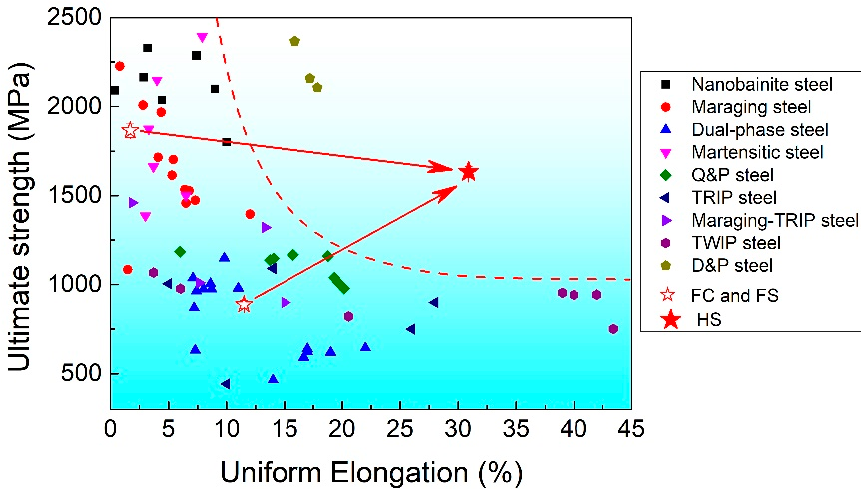
Figure 13. Representative tensile properties of steel. The properties of the studied steels are marked with red stars.